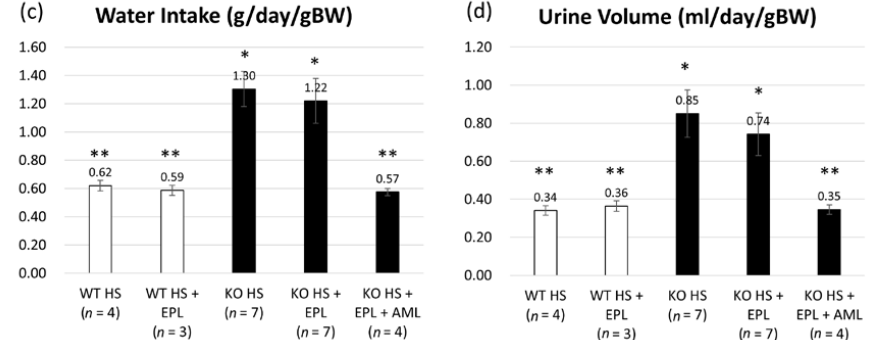
Figure 2. Water intake (WI) and urine volume (UV) measured daily. Averages of WI ( a ) or UV ( b ) from days 1 to 10 in each group. Analyzed by two-way repeated ANOVA. Averages of total WI ( c ) or UV ( d ) in each group analyzed by one-way ANOVA. Data are from wild-type mice on a high-salt diet ( n = 4), wild-type mice on a high-salt plus EPL diet ( n = 3), Nedd4-2 C2 KO mice on a high-salt diet ( n = 9), Nedd4-2 C2 KO mice on a high-salt plus EPL diet ( n = 9), and Nedd4-2 C2 KO mice on a high-salt plus EPL diet, treated with AML ( n = 4). * p < 0.01 compared with WT HS, WT HS + EPL, and KO HS + EPL + AML; ** p < 0.01 compared with KO HS and KO HS + EPL. # p < 0.05 compared with WT HS, WT HS + EPL, and KO HS + EPL + AML; ## p < 0.05 compared with KO HS and KO HS + EPL. The urine Na + /K + ratio was calculated daily by determining the urine sodium and potassium concentrations. A significant reduction was observed in Nedd4-2 C2 KO mice compared to WT littermates (5.06 ± 0.20 vs. 6.25 ± 0.16, p < 0.001), and EPL generally increased the Na + /K + ratio both in Nedd4-2 C2 KO mice and WT littermates (5.50 ± 0.16 and 6.41 ± 0.18), as shown in Figure 3a,b. This indicates that sodium reabsorption via ENaCs was increased in Nedd4-2 C2 KO mice and that EPL inhibited the function of renal outer medullary K+ channel (ROMK). AML inhibited ENaCs, and the Na + /K + ratio increased in Nedd4-2 C2 KO mice similar to that in WT littermates.